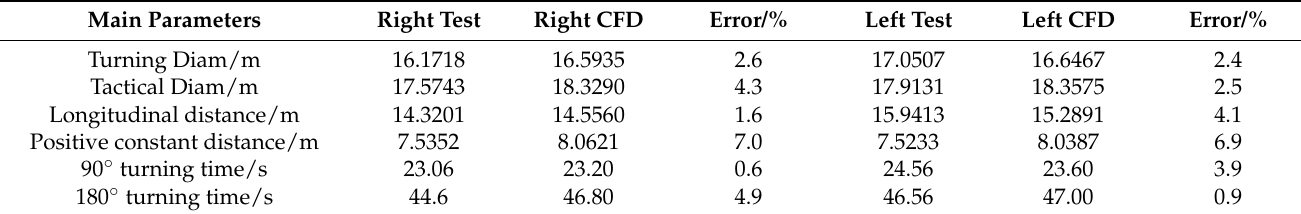
Table 6. Comparison of characteristic parameters of turning circle.